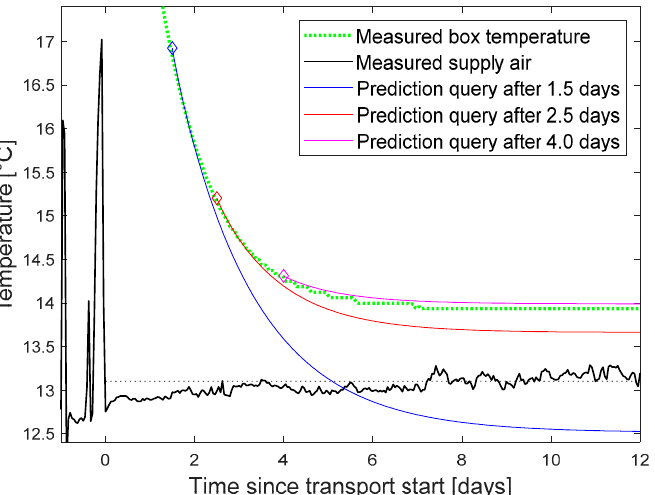
Figure 7. Measured and predicted temperature. Prediction for assumed constant supply air temperature of 13.2 °C.